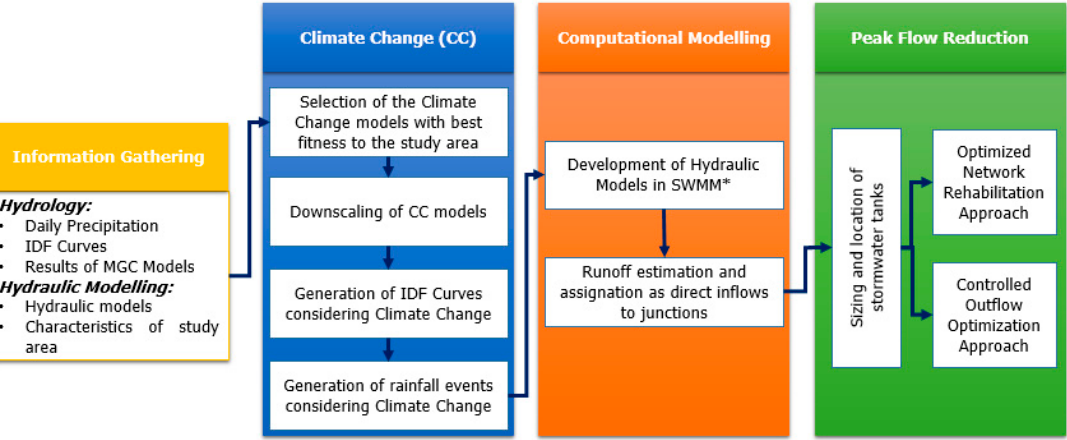
Figure 2. General description of the methodology proposed for the optimal sizing and location of stormwater tanks considering Climate Change.